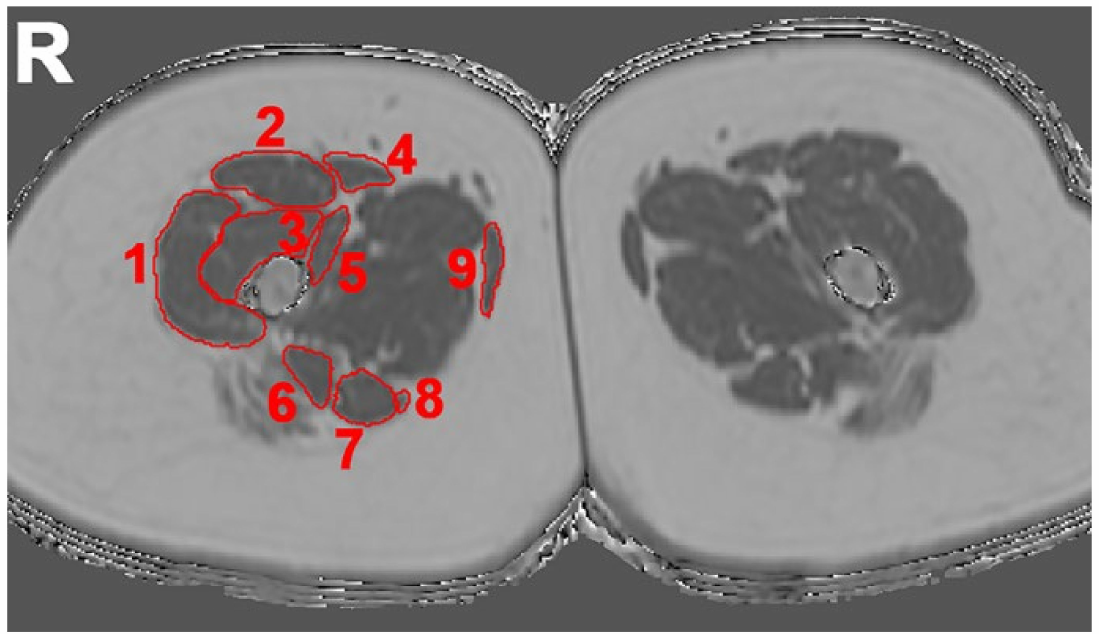
Figure 1. Segmentation masks on a representative axial slice of the PDFF map at the thigh region. Manual segmentation masks separately enclosing the vastus lateralis ( 1 ), rectus femoris ( 2 ), vastus intermedius ( 3 ), sartorius ( 4 ), vastus medialis ( 5 ), biceps femoris ( 6 ), semitendinosus ( 7 ), semimembranosus ( 8 ), and gracilis ( 9 ) muscles of the left and right thigh region, respectively. R